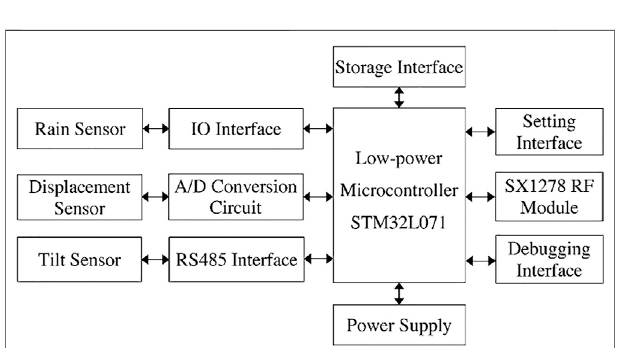
FIGURE 7 | Structure diagram of data collection